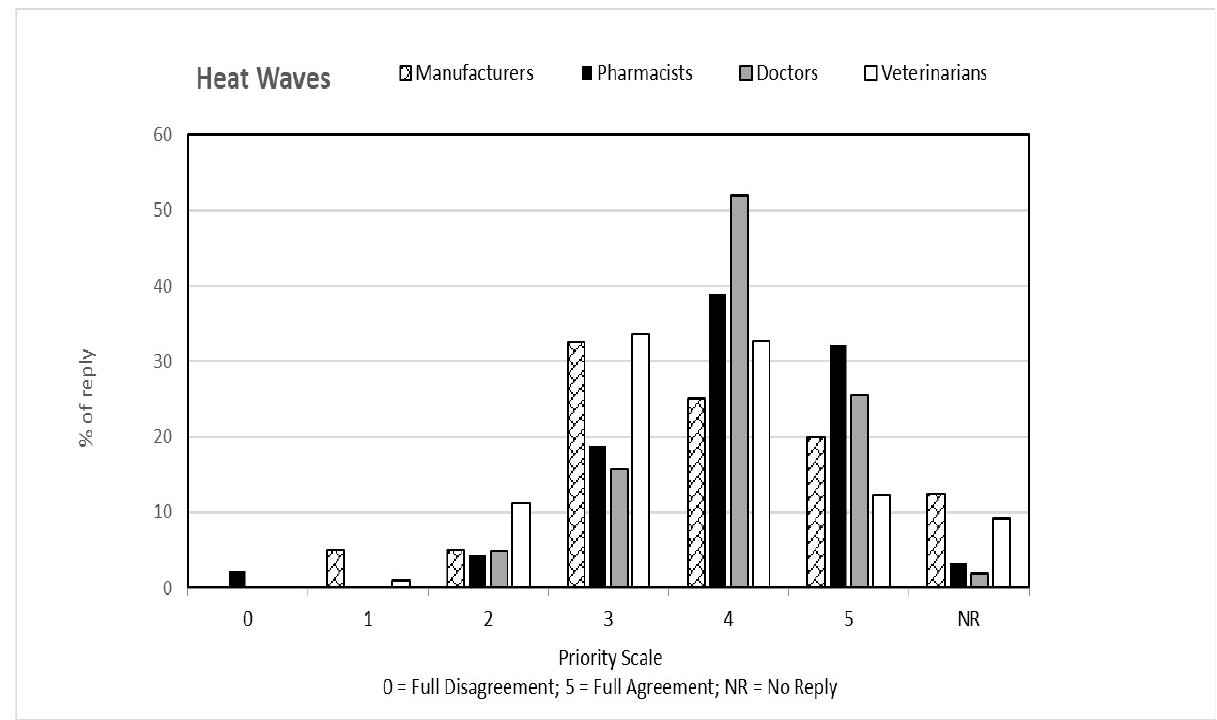
Figure 1. Percentage of answers “HEAT WAVES” to the question “Global Environmental Changes manifest themselves with ....” given by the four interviewed categories. The tables also include the percentage of “no reply” (NR) responses.